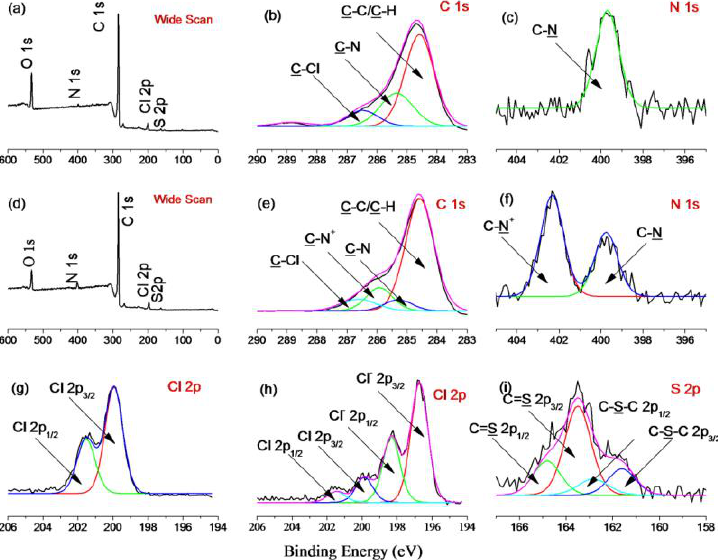
Figure 2. ( a ) Wide scan, ( b ) C 1s, ( c ) N1s, ( g ) Cl 2p, and ( i ) S 2p XPS results for PVC nanoparticles and ( d ) wide scan, ( e ) C 1s, ( f ) N1s, and ( h ) Cl 2p XPS results for PVC@TAA